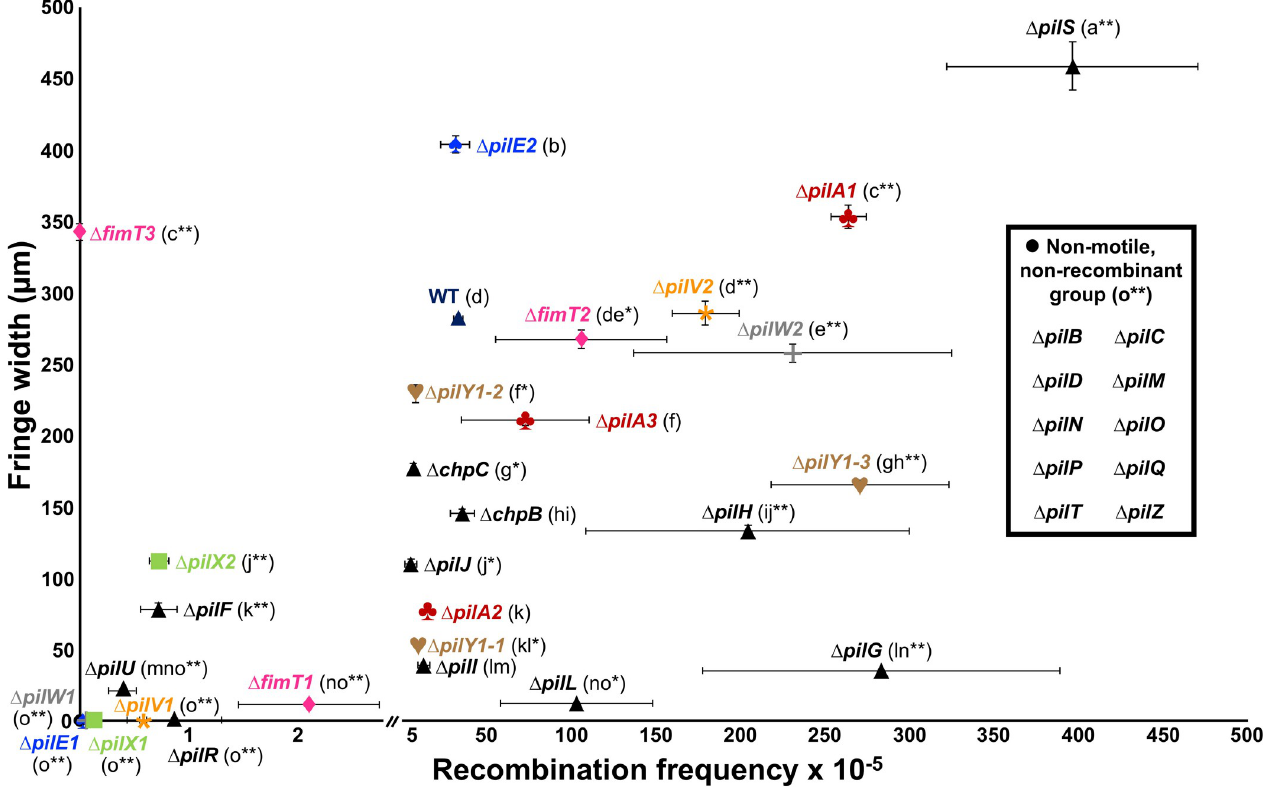
Fig 1. Natural transformation and twitching motility phenotypes of X . fastidiosa mutant strains used in this study. Quantification of natural transformation was performed by enumerating total viable and recombinant culturable cells and results are expressed as the ratio of recipient cells transformed (recombination frequency; values shown in the x-axis of the chart). Twitching motility was determined by spotting cells on agar plates and measuring the movement fringe width after 4 days of growth at 28˚C (values shown in the y-axis of the chart). Results of mutant strains for paralogous genes are shown using the same color for text and symbol. The non-motile and non-recombinant mutants are shown as a black dot. The WT is represented as a dark blue triangle and all other mutants are represented as black triangles. Data represent means and standard errors. Different letters in parenthesis indicate significant difference in fringe width as analyzed by ANOVA followed by Tukey’s HSD multiple comparisons of means ( P < 0.05; n = three to 14 independent replicates with eight to 48 internal replicates each). � and �� indicate significant difference ( P < 0.05 and P < 0.005, respectively) of recombination frequency through natural competence in comparison to the WT as determined using Student’s t -test (n = three to 21 independent replicates with two internal replicates each). The detection limit for recombination frequency was 10 − 7 and for twitching motility was 10 μ m. Mutants below the detection limit are shown in the non-motile and non- recombinant